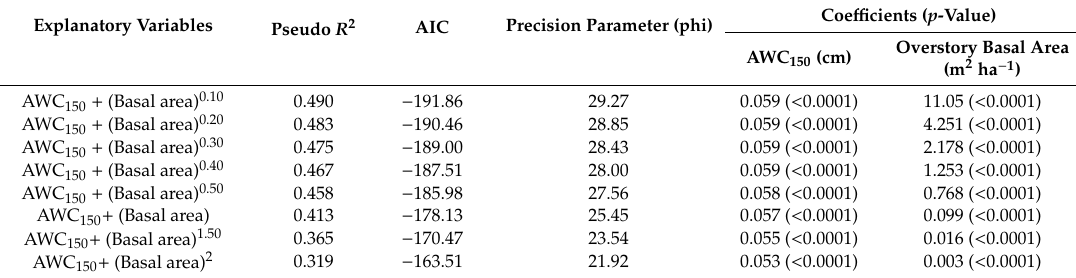
Table 4. Pseudo- R 2 , Akaike Information Critirion (AIC), and precision parameter for selected beta regression models. Estimated coe ffi cients with p -value in parentheses are given for each explanatory variable. The final beta regression model is highlighted in black